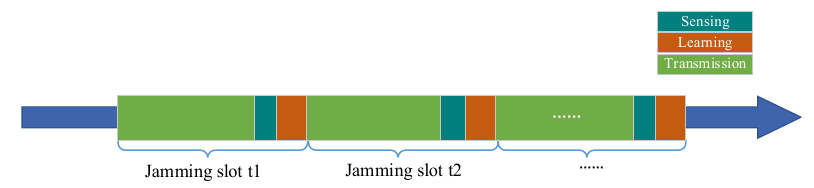
Figure 2. Structure of the communication time slot. Figure 3 is a state transition diagram between the actual state and the observed (sensing) state for channel i due to the existence of false alarm and missed detection. Where p i is the missed detection probability, indicating that the observation state is no jamming, while the actual state is jamming. q i is the false alarm probability, indicating that the observation state is jamming, while the actual state is no jamming.